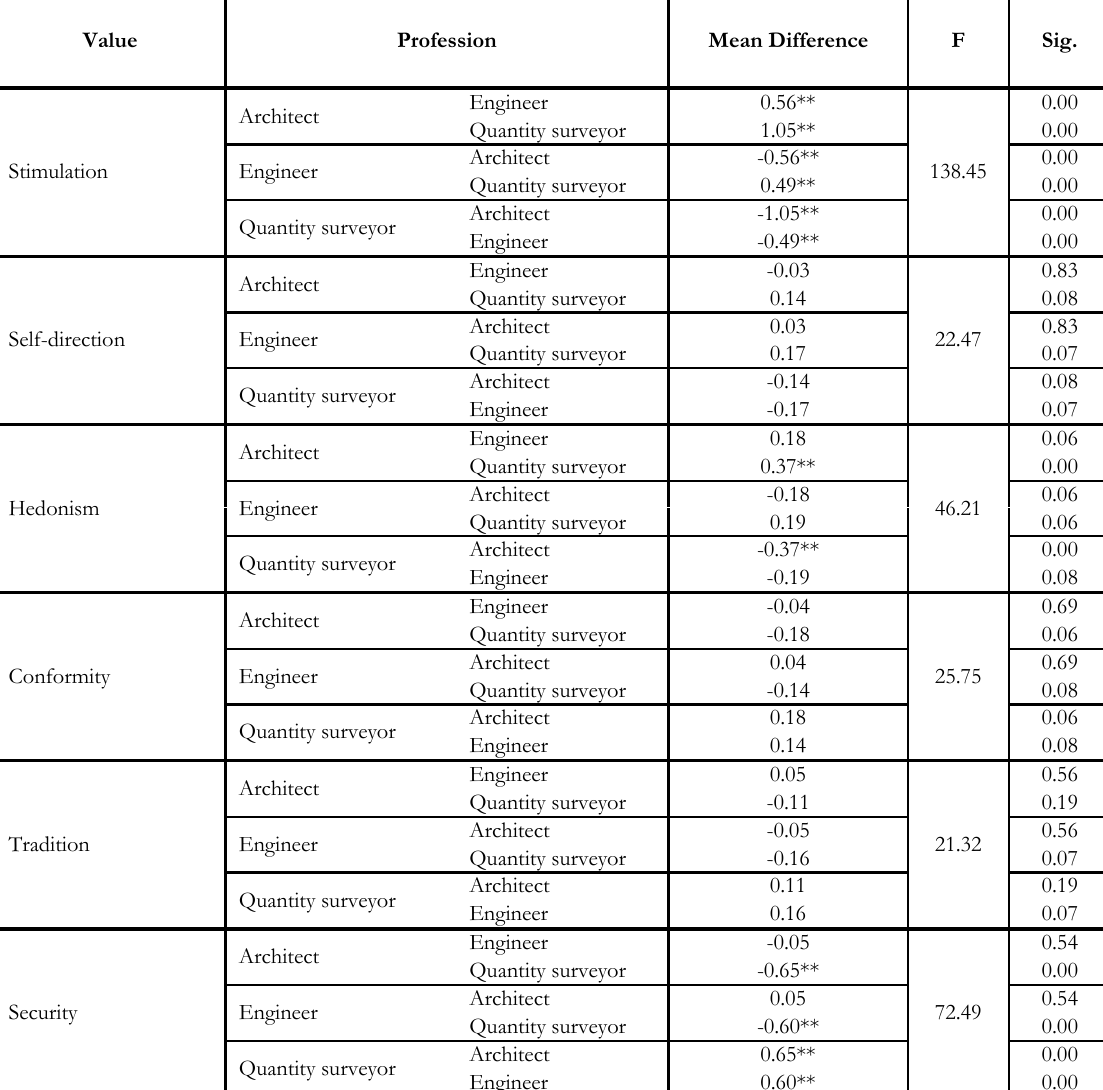
Table 4: Comparative analysis of the professions based on the 15 value types Value Profession Mean Difference F